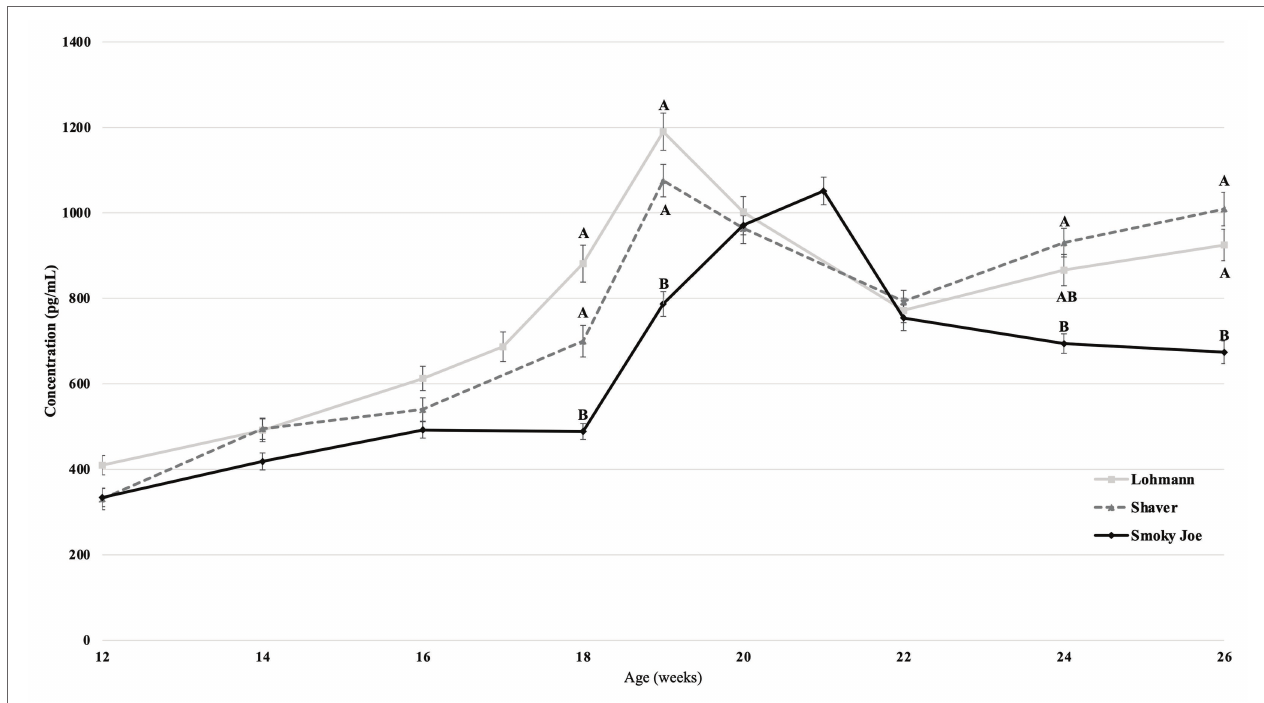
FIGURE 2 | Estradiol (E 2 ) concentration in Lohmann, Shaver, and Smoky Joe hens from 12 to 26 woa ± SEM. p -values for the sources of variation: Age, p < 0.0001; Strain, p < 0.0001; Age * Strain, p < 0.0001. A,B represent the significance level between strains at each age. Strains at each timepoint lacking a common subscript demonstrate a significance of p <